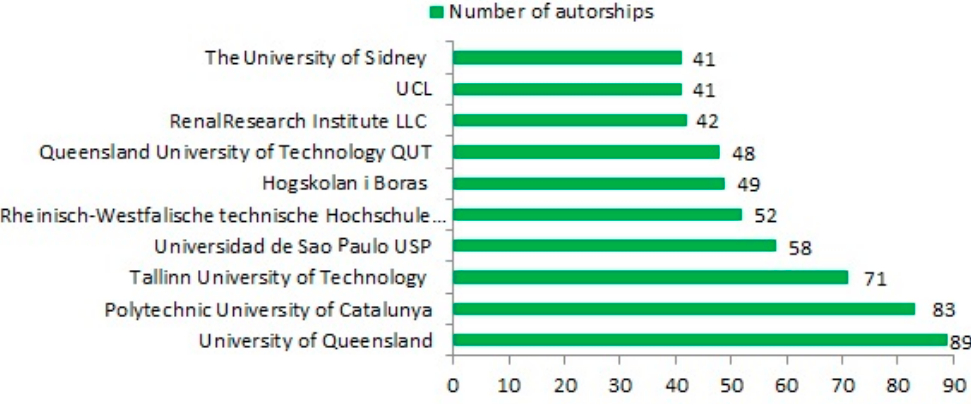
Figure 6. Ranking of the top 10 institutions publishing on bioimpendance.